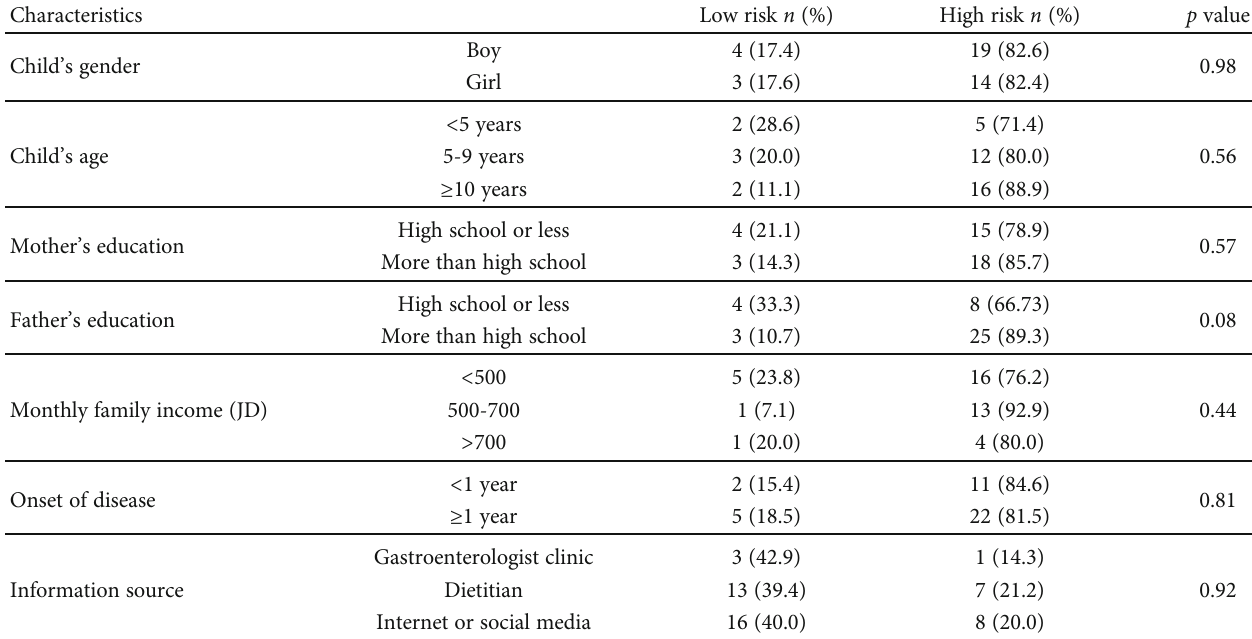
Table 3: Relationship between attitude and practice categories among CD parents and the sociodemographic characteristics of CD patients and their